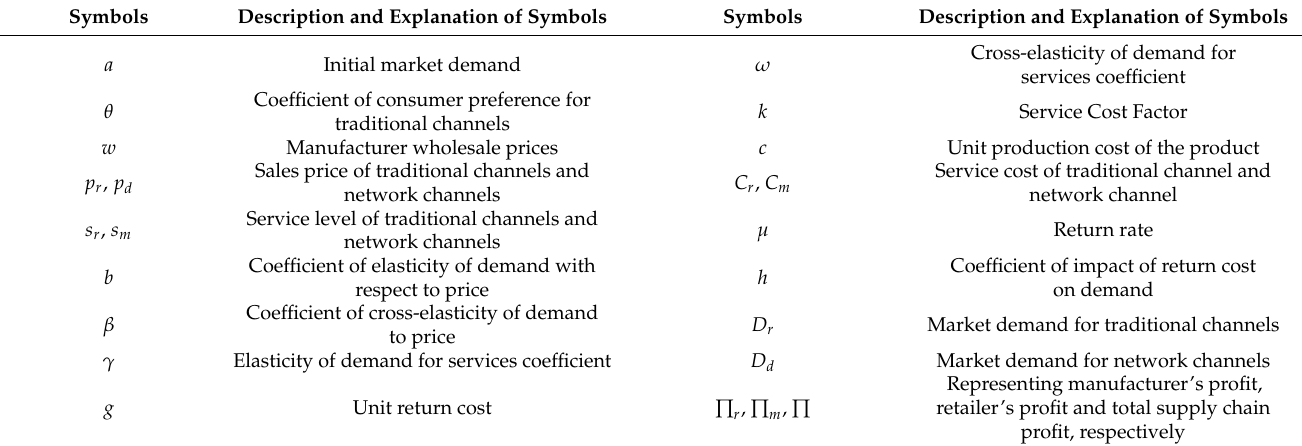
Table 1. Description and interpretation of model symbols.